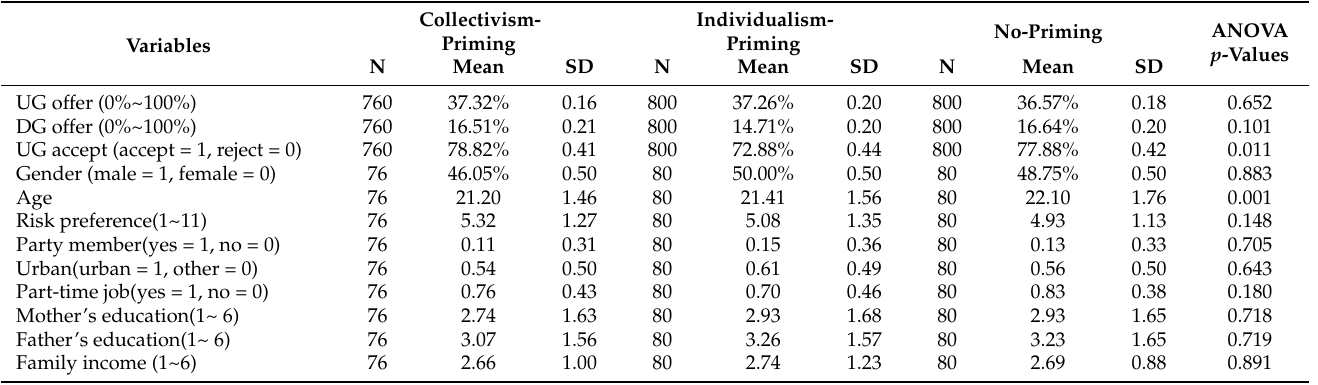
Table 1. Descriptive statistics by